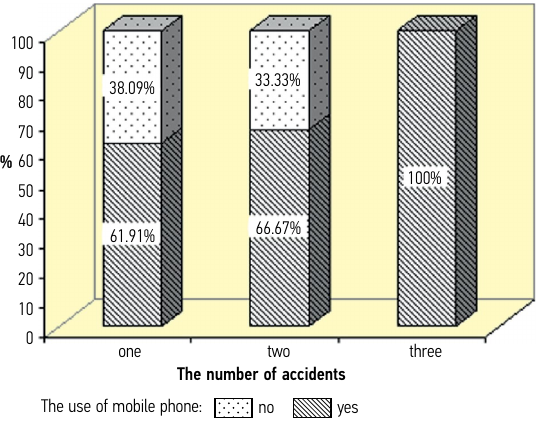
Fig. 6. The usage of mobile phones and the number of traffic